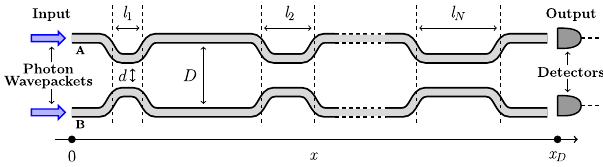
pairs of polaritons are created at x = 0 and many-body interactions are then detected at x D by measuring the degree of correlation of photons emerging from the two channels. In this work, we will assume that each input is a single photon state. The device consists of a sequence of N interaction regions of length l j ( j = 1, 2, ⋯ N ) where the two waveguides (labeled as A and B ) run in parallel at a distance equal to d so that they are evanescently coupled. Two consecutive interaction regions are separated by a free- propagation region, that is a portion of the device where the distance between the two waveguides is D ≫ d and the coupling between the two waveguides is